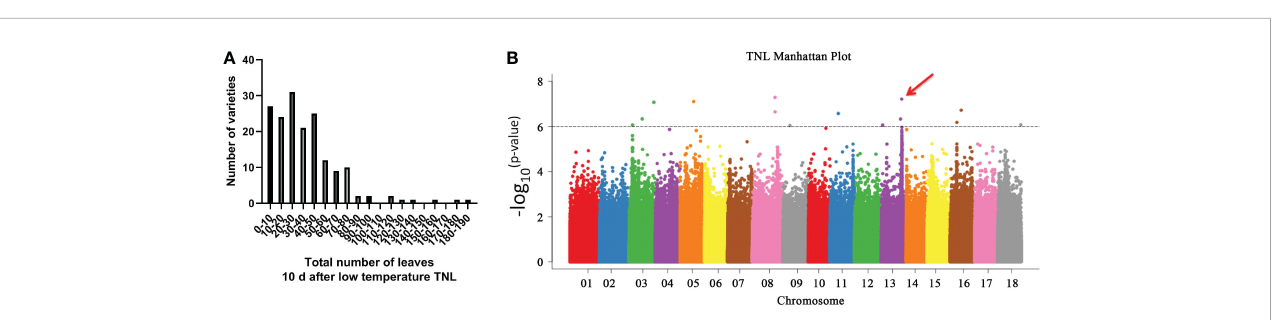
FIGURE 6 Genome-wide association studies (GWAS) analysis revealed that MebHLH18 is involved in low temperature-induced leaf abscission. (A) Frequency distribution of the total number of leaves at 10 days after low temperature (TNL). (B) Manhattan map of the TNL phenotype. Six quantitative trait loci (QTLs) had TNL values greater than the threshold of signi fi cance induced by low temperature-induced leaf abscission. The GWAS peak on chromosome 13 is located in a QTL, Manes. 13G105700 ( MebHLH18 ), which has a peak value. The red arrow indicates the location of the MebHLH18 gene.